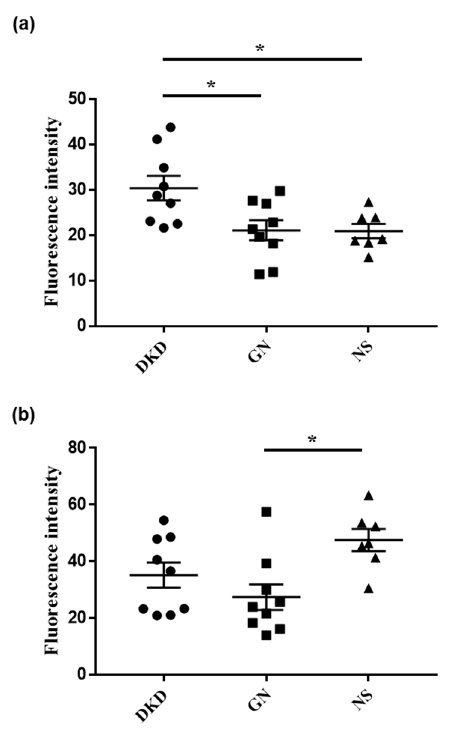
Figure 4. Fluorescent intensities of urine in patients with diabetes. Urinary fluorescent intensities after incubation with DPP-HMRG ( a ) and GGT-HMRG ( b ) in patient with diabetes. Diabetic kidney disease could be distinguished from the other groups by DPP-HMRG, whereas nephrosclerosis could be differentiated from glomerulonephritis by GGT-HMRG. *; p < 0.05.